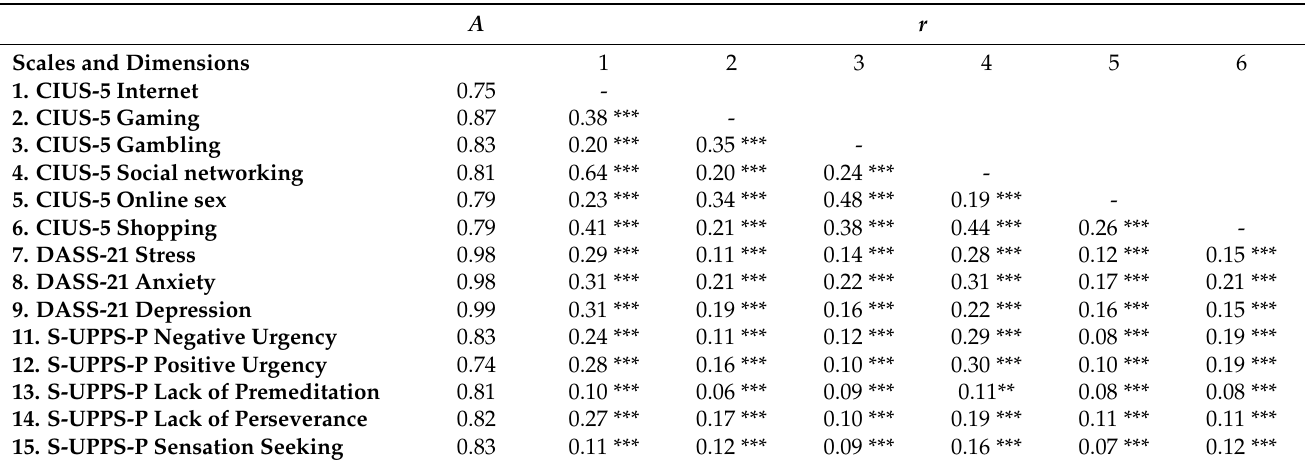
Table 4. Correlation matrix and global reliability of problematic internet use and psychopathological and personality measures of the overall